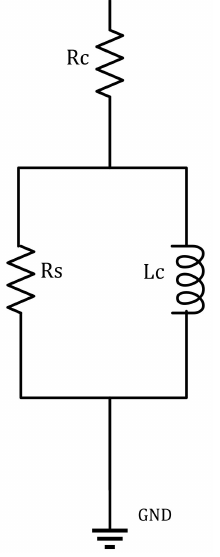
Figure 1. Conventional grounding system impedance